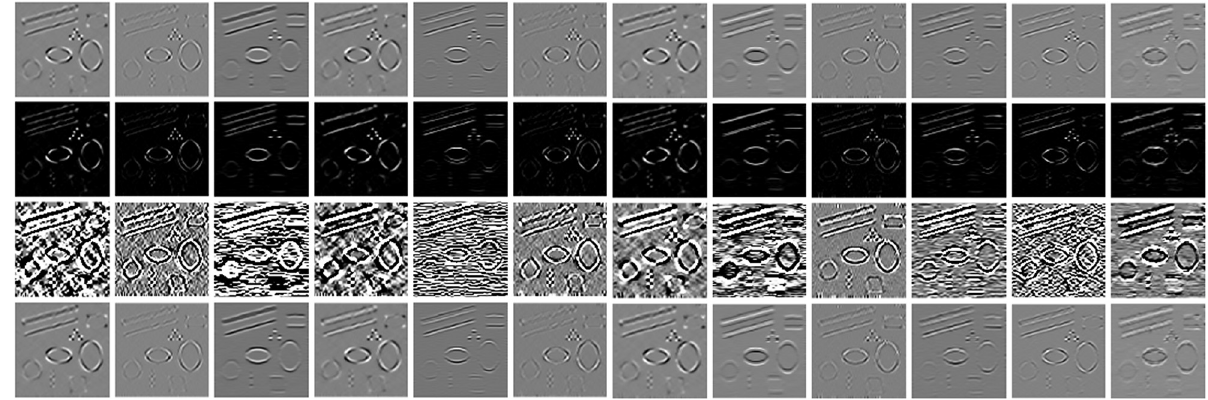
Fig 4. Comparisons of the learned feature images by various activation functions in the PCANet. The top row, the second row, the third row and the bottom row show the learned feature images by the original PCANet, ReLU-based PCANet, sigmoid-based PCANet and PReLU-based PCANet models,